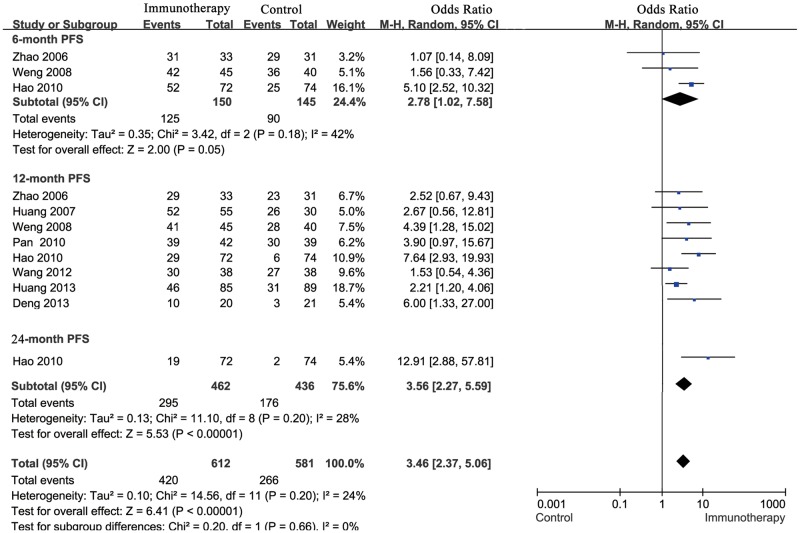
Comparison of 6, ≥12-month PFS between the patients who received cellular immunotherapy or not by using the random effects model (Mantel-Haenszel method).